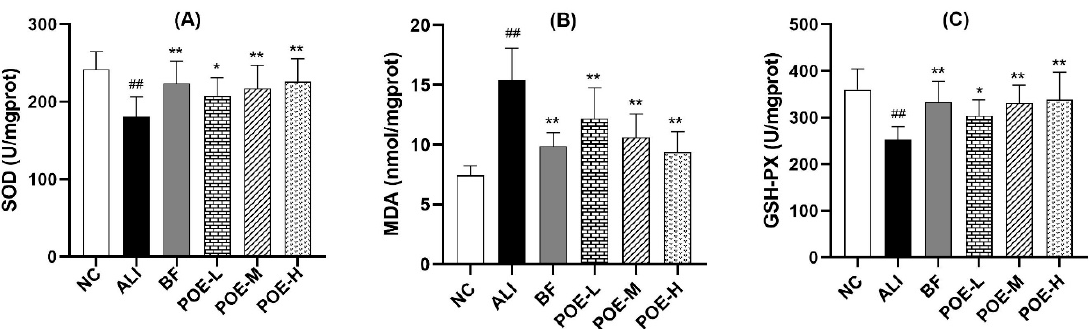
Figure 2. Effects of POE on oxidative damage index in alcoholic liver injury rats. ( A ) SOD activity, ( B ) MDA content, ( C ) GSH-PX activity. Values are presented as Mean ± SEM, n = 10. ## p < 0.01 compared with NC group. * p < 0.05 and ** p < 0.01 compared with ALI group.